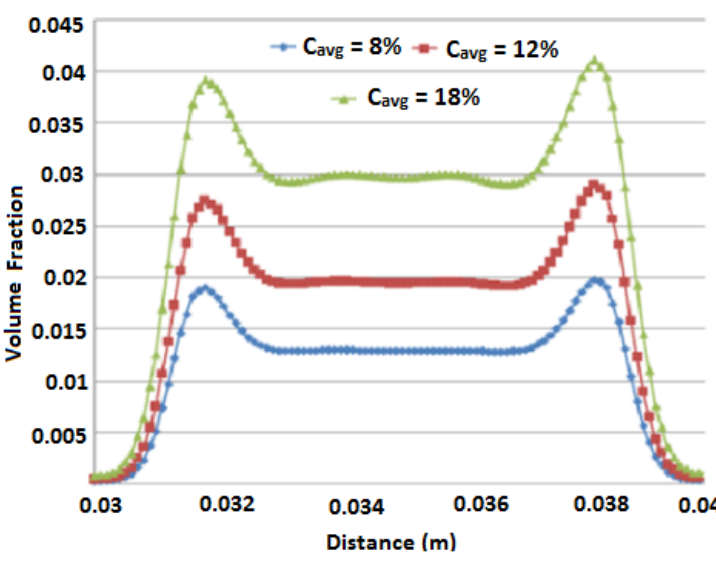
Figure 10. Comparison of solid phase volume fraction for different initial solid phase concentration in slurry sample W 3 for R OH = 0.02 (33 RPM) and constant V = 7.78 m/s along Plane